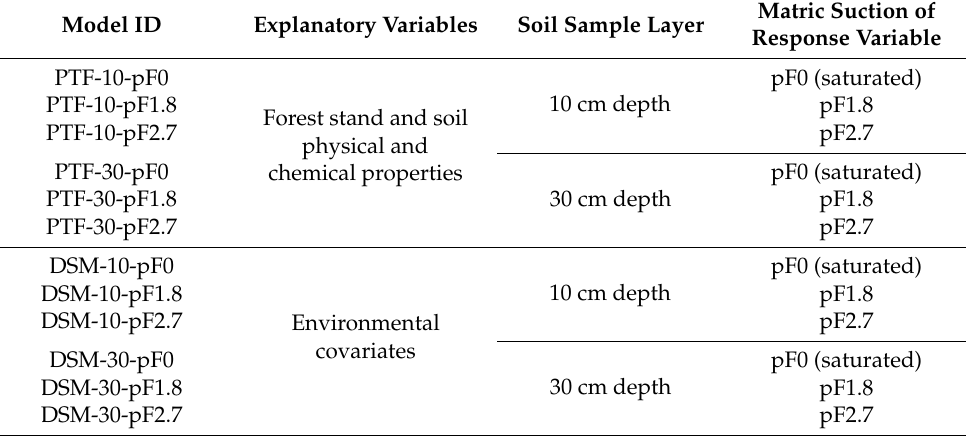
Table 2. Developed